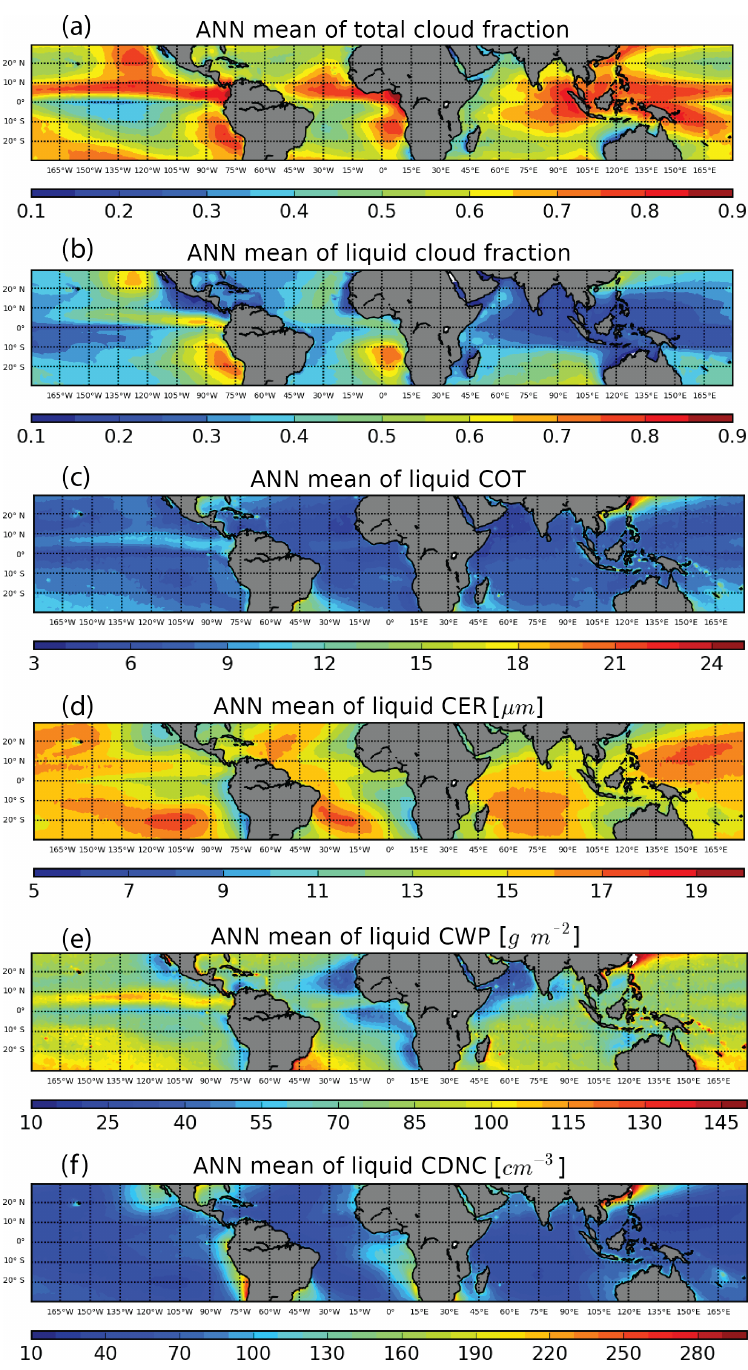
Figure 4. Ten-year (2007–2016) averaged annual mean (a) total cloud fraction, (b) liquid cloud fraction, (c) cloud optical thickness, (d) cloud effective radius retrieved from the 3.7µm band, (e) cloud water path, and (f) cloud droplet concentration retrievals from Aqua MODIS over the tropical (30 ◦ S–30 ◦ N) oceans. All quantities are in-cloud means that are averaged over the cloudy part of the grid